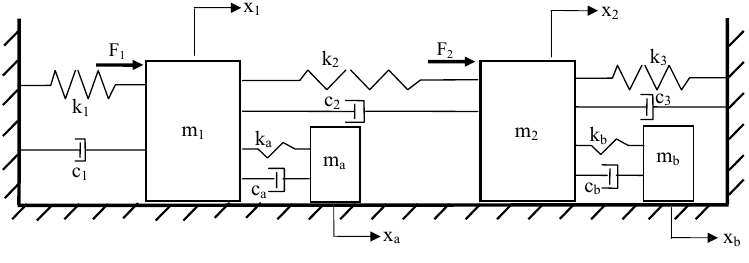
Fig. 5. System of two main masses with two